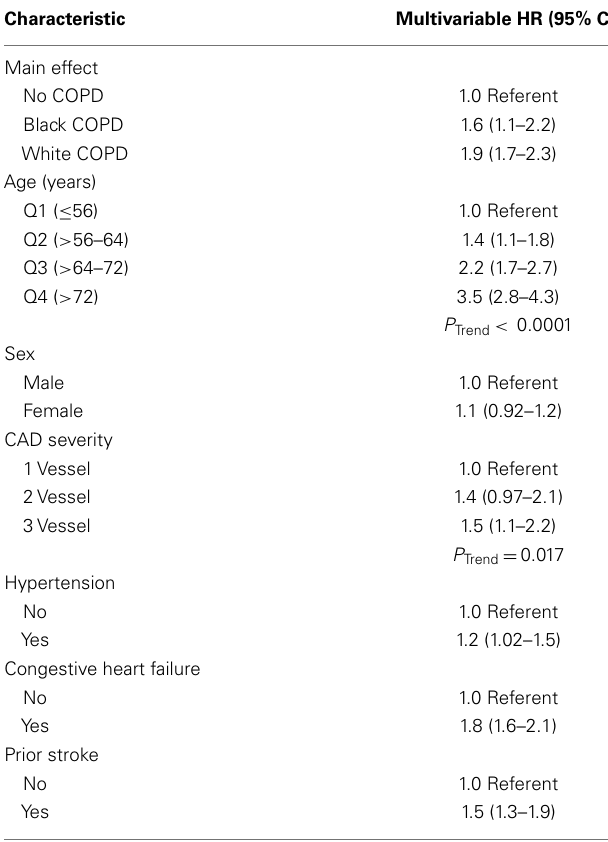
Table 2 | Multivariable survival after